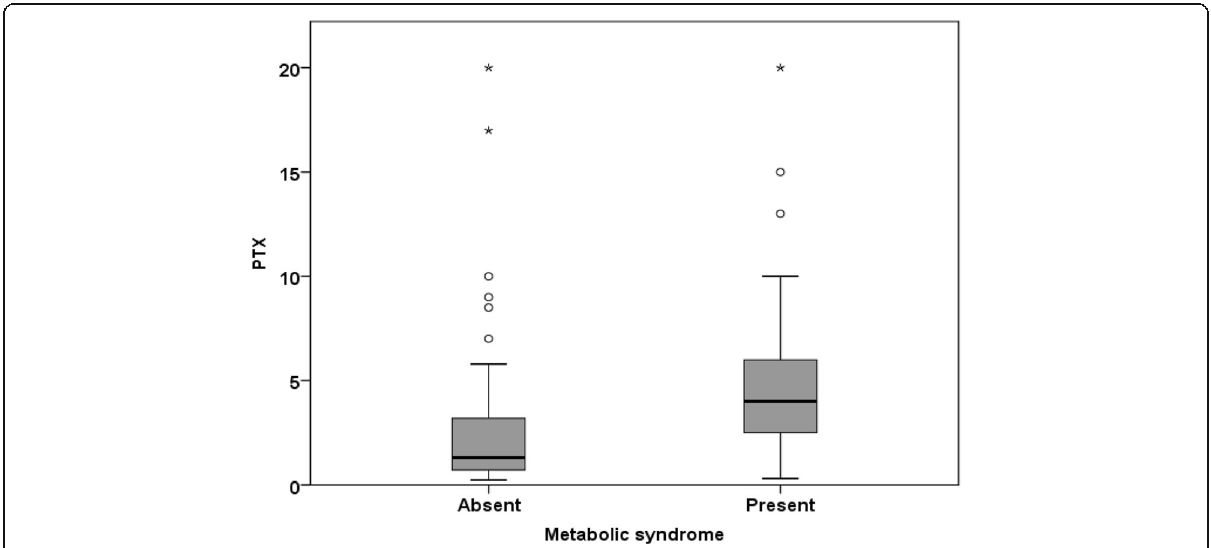
Fig. 1 Box-plot chart showing values of PTX3 (median, range) in the presence or absence of metabolic syndrome